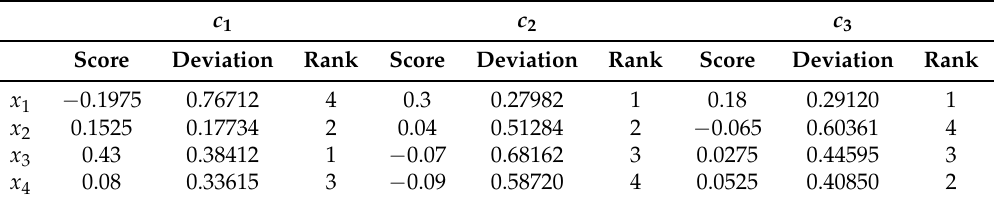
Table 6. Score and deviation values of PDHFEs in matrix R